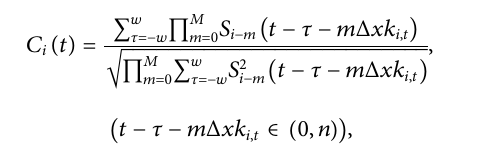
Frontiers in Earth Science |